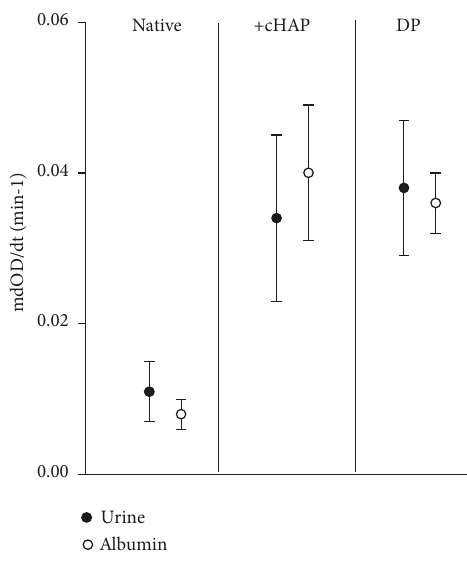
Figure 2: Maximal decrease of optical density (mOD/dt) in crys- tallization tests performed in urine and albumin solution (AS, 20 mg/ml) without (native) and after the addition of UM coated hydroxyapatite (+cHAP, 0.05 mg/ml) and in dissolved Caphosphate precipitates (DP) from urine and AS.